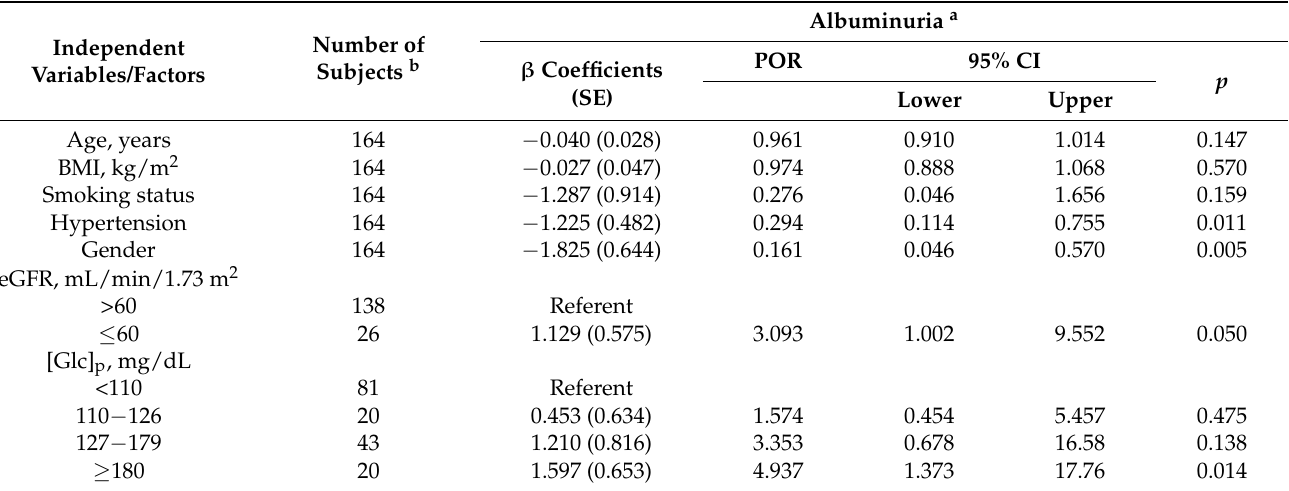
Table 5. Association of the prevalence odds for albuminuria with abnormal fasting plasma glucose levels.